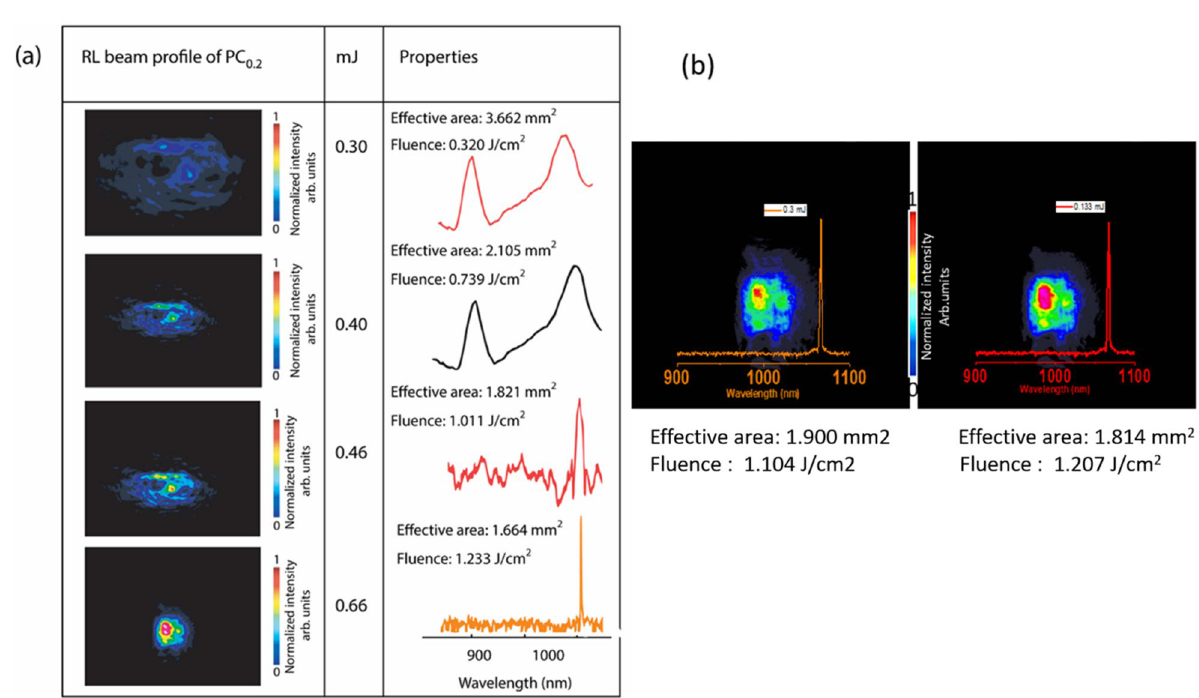
Figure 3. ( a ) Properties of the observed RL beam profile for polymer composite PC0.2 at different excitation energies, ( b ) the random laser beam profile of sample PC1.0 and lasing emission at pump energies of 0.16 and 0.3